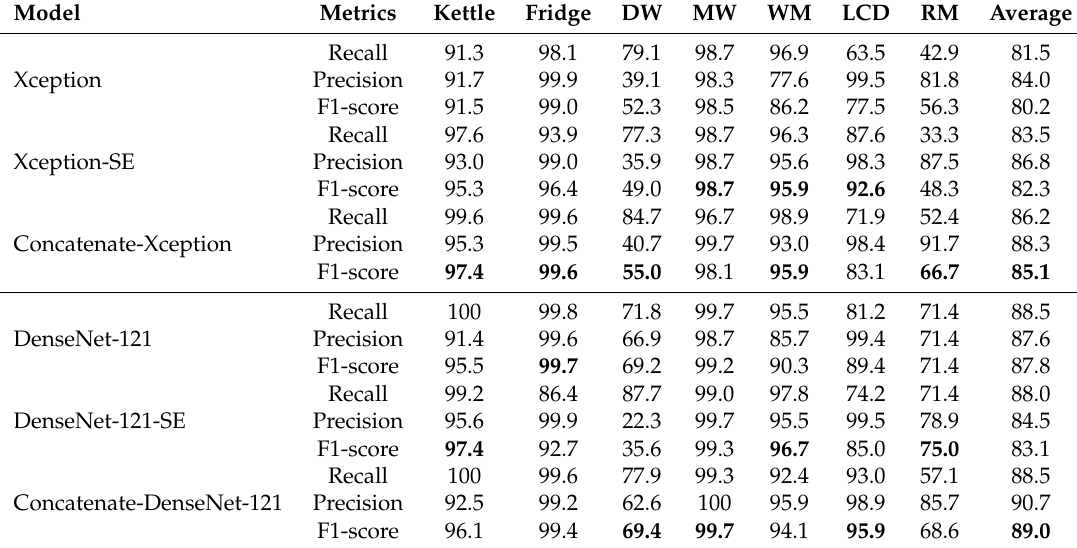
Table 4. Comparison of the proposed model and two baselines on house 2 data of the